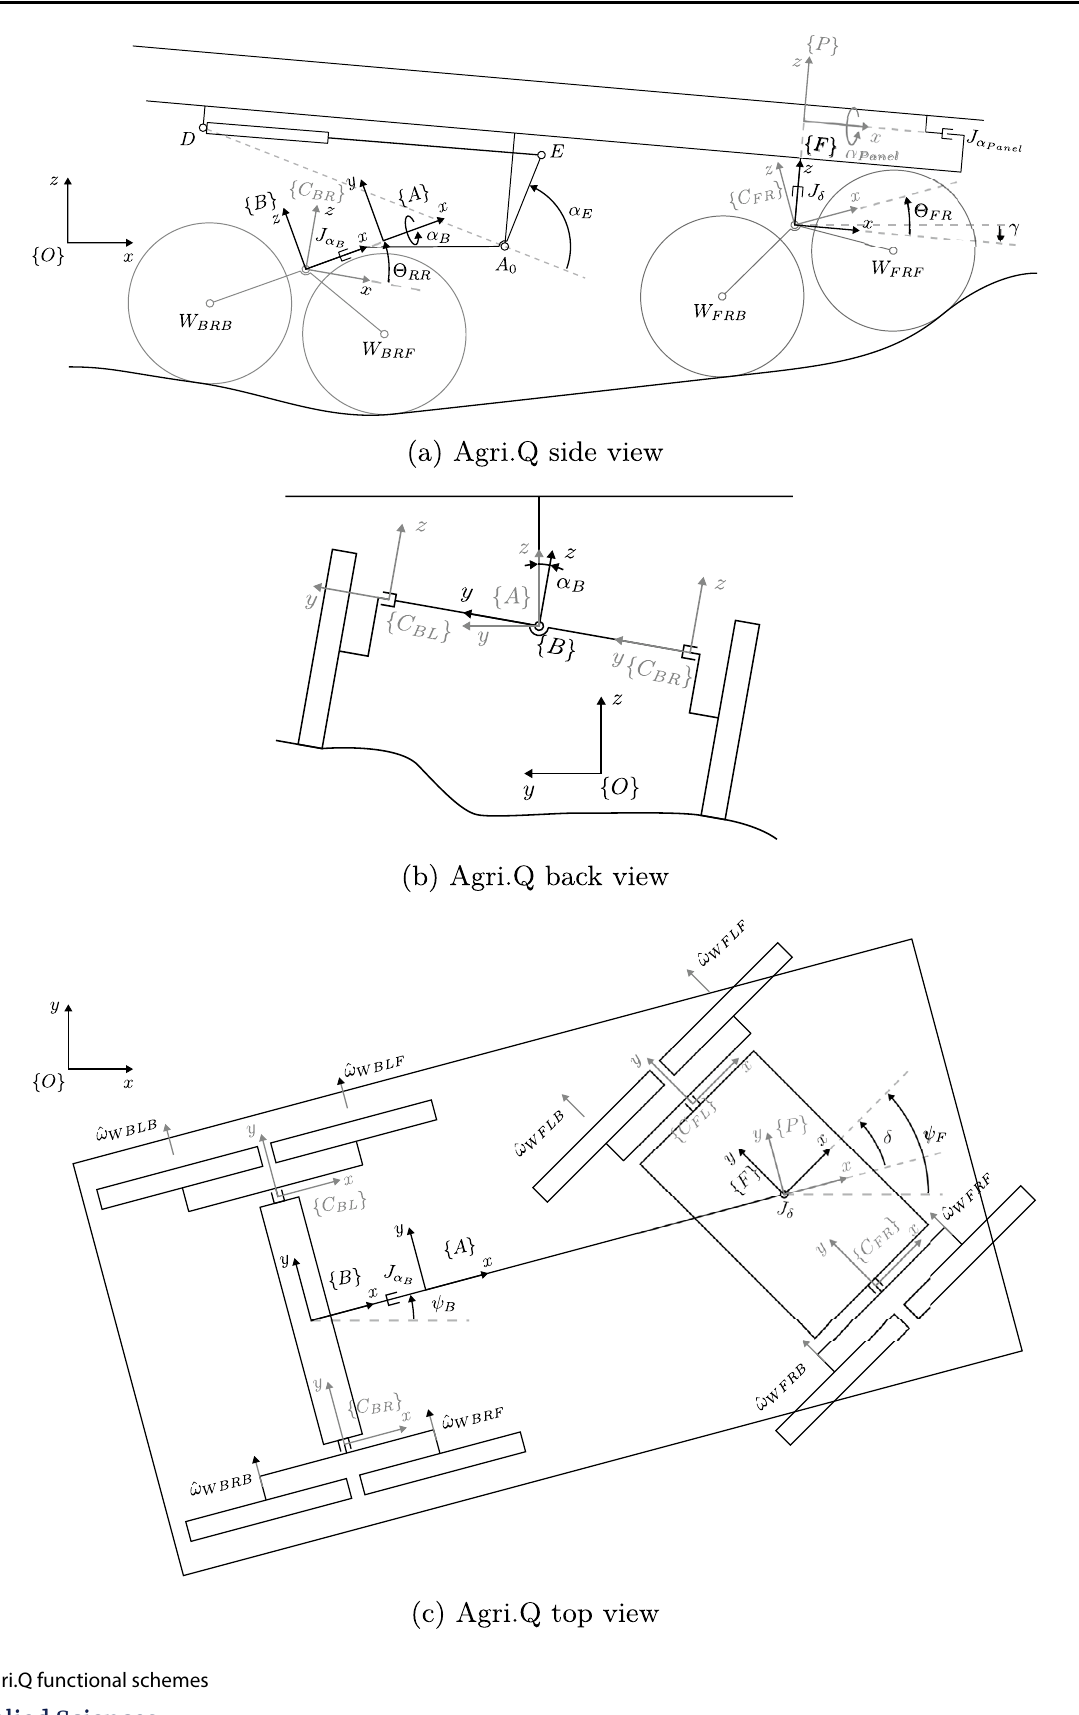
Fig. 2 Agri.Q functional